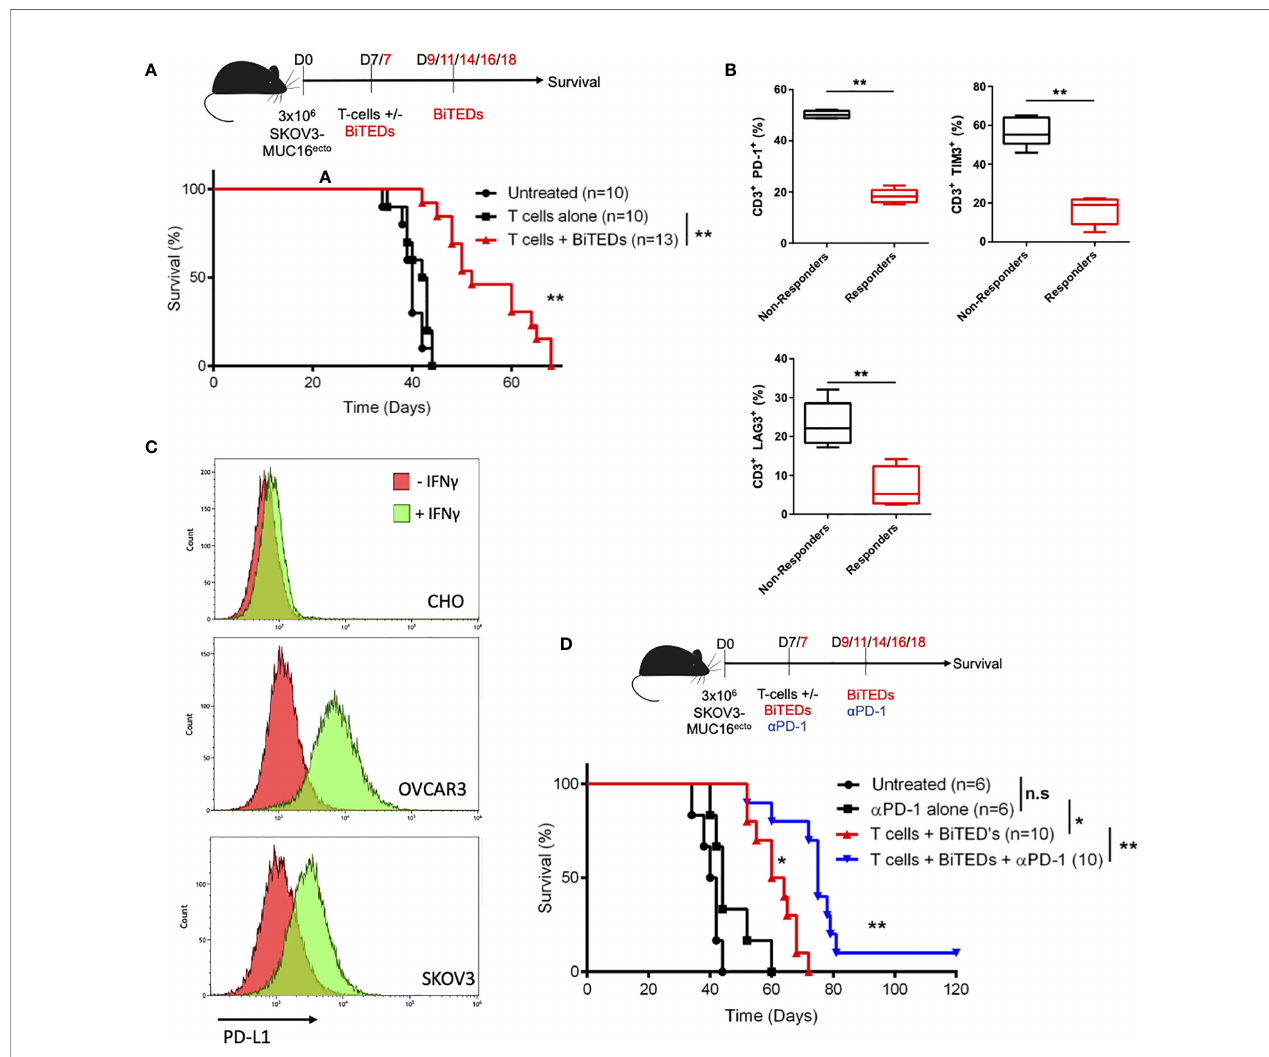
FIGURE 5 | MUC16 ecto -BiTEDs improve overall survival in tumor-bearing mice as monotherapy and in combination with PD-1 immune checkpoint blockade. (A) NSG tumor-bearing mice were inoculated i.p. with SKOV3-MUC16 ecto tumor cells and treated with either T-cells alone or T-cells and MUC16 ecto -BiTEDs. Data shown are pooled results from 3 independent experiments with at least 4 independent donors. Data are plotted as mean ± SEM. **p < 0.05. Tumor was injected on D0 i.p. T-cells were injected on D7 i.v in all animals. Animals that received BiTEDs treated were dosed i.p on D7, D9, D11, D14, D16 and D18. (B) Immunophenotyping of human T-cells from the spleens of female NSG SKOV3-MUC16 ecto tumor-bearing mice treated with BiTEDs who had either succumbed to disease (Non-Responders) or from those who lived longer (Responders). **p < 0.05. (C) CHO, OVCAR3 and SKOV3 cells with or without IFN- g stimulation for 24 hrs. Data shown representative of 2 independent experiments. (D) SKOV3-MUC16 ecto tumor-bearing mice were treated with T-cells and a PD-1 alone, T-cells and BiTEDs, or T-cells, a PD-1 and BiTEDs. Tumor was injected on D0 i.p. T-cells were injected on D7 i.v in all animals. Animals that received BiTEDs treated were dosed i.p on D7, D9, D11, D14, D16 and D18. Anti-PD-1 (clone EH12.2H7) was injected i.p. on D7, D14, D21 and D28. Data shown are pooled results from 3 independent experiments with at least 4 independent donors. Data are plotted as mean ± SEM. *p < 0.05 T-cells + a PD-1 vs T-cells + BiTEDs, **p < 0.05 T-cells + BiTEDs vs T- cells + BiTEDs + a PD-1. Statistical analysis for (A, C) performed using a log-rank (Mantel-Cox) test. ns, not signi fi